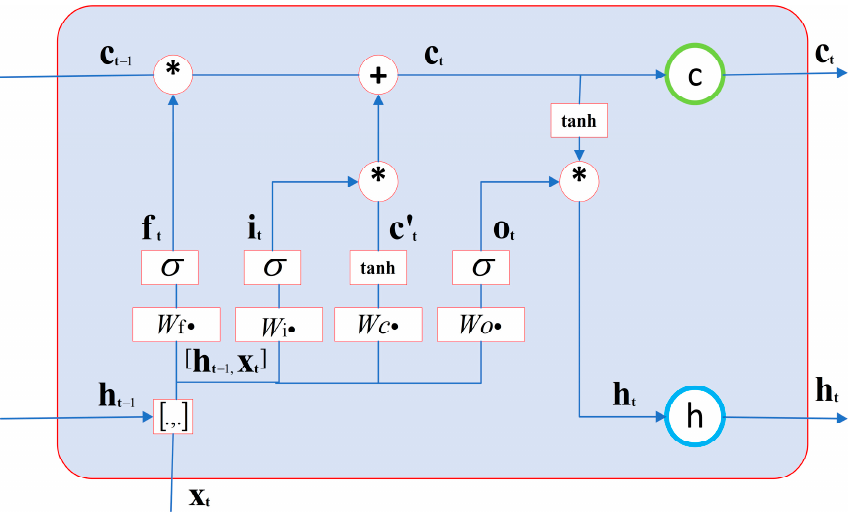
Figure 5. The calculation process of LSTM (* denotes the Hadamard product of the matrix). The forget gate determines how much of the previous moment’s cell state is retained at the current moment.